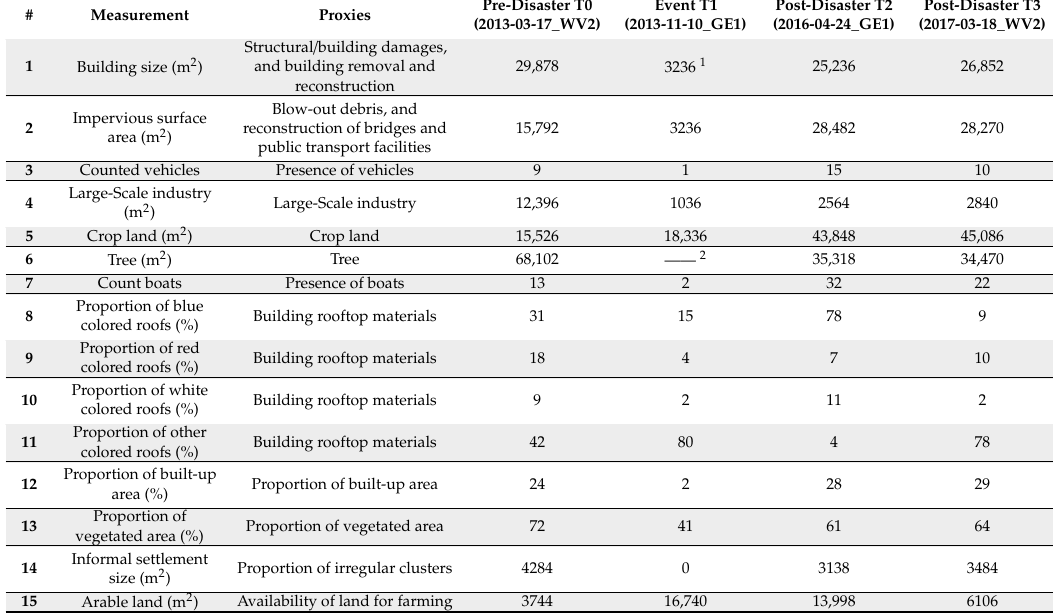
Table 6. The extracted results for the selected proxies for Barangay 69, Tacloban. WV2: WorldView2; GE1: